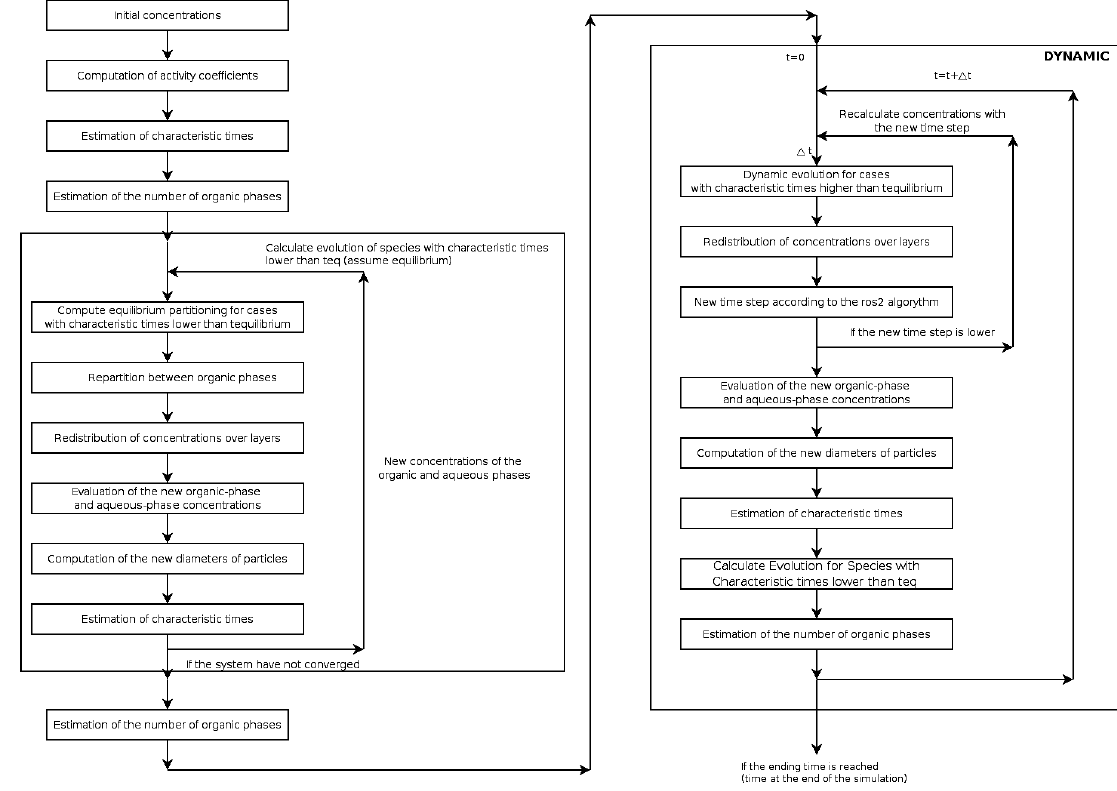
Figure 5. Diagram of the method used to compute the evolution of